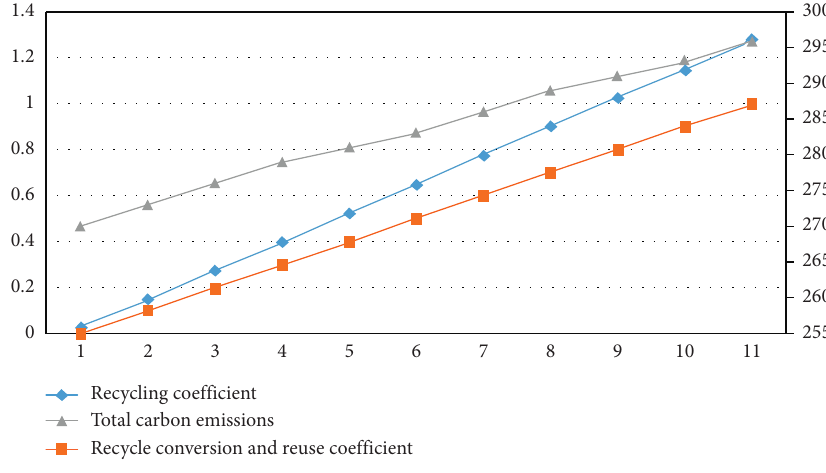
Figure 2: Change of total carbon emission with r